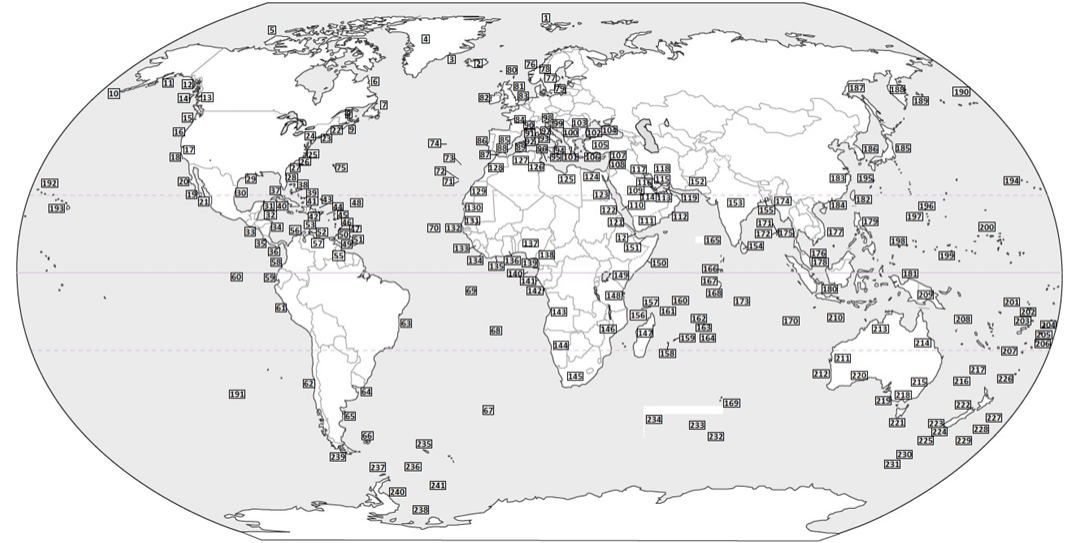
Figure 1. The global distribution of the three coralline algae Families (Corallinaceae, Hapalidiaceae and Sporolithaceae; for species list per country/region see Table S2). The numbers indicate: 1. Spitsbergen, 2. Iceland, 3. Greenland, east, 4. Greenland, 5. Canada, Arctic,